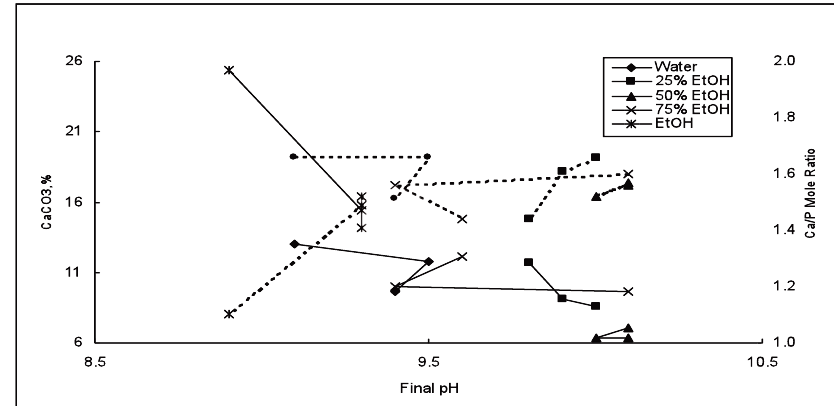
Figure 5. Effect of solvent on the reaction at 80°C.